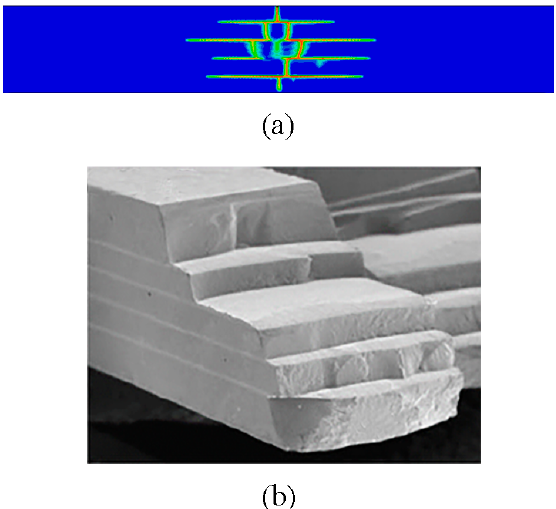
Figure 5. Comparison between the numerical simulation results ( a ) of four-point bending and experimental results ( b ) when the layer thickness ratio was R = 5 [37].